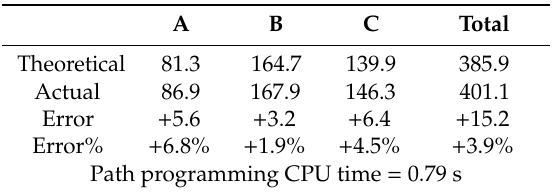
Table 2. The Comparison of Shortest Total Distance (Theoretical) and Total Experimental Trajectory (Actual) under the Constraint of the Maximum Distance Limit of 170 m for Each Car.